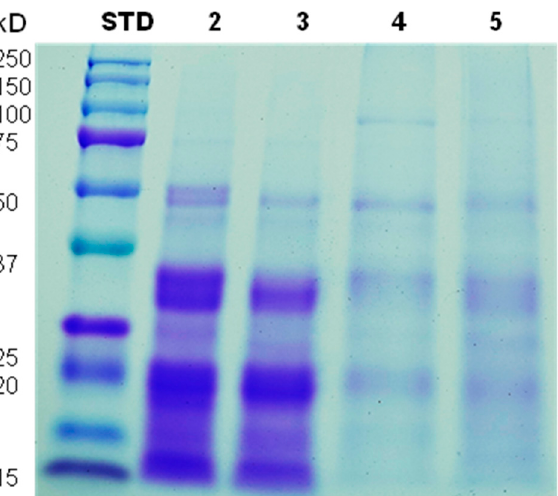
Figure 3. SDS-PAGE of chickpea protein isolates from sequential extractions and ovalbumin. STD: Standard protein markers; (2) Extraction total; (3) Albumin fraction; (4) Globulin fraction; (5) Glutelin fraction.